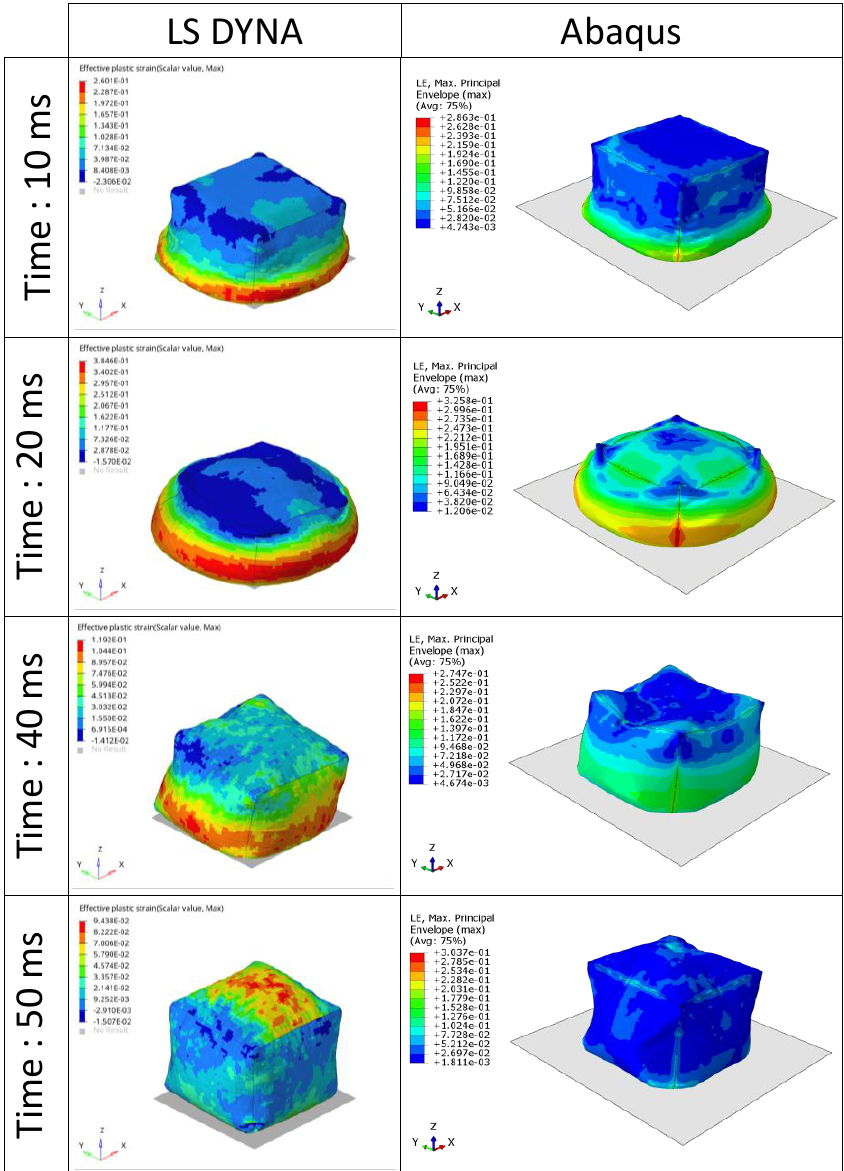
Figure 7. Strain distribution on tank structure. Left: Ls-Dyna model; right: Abaqus model.